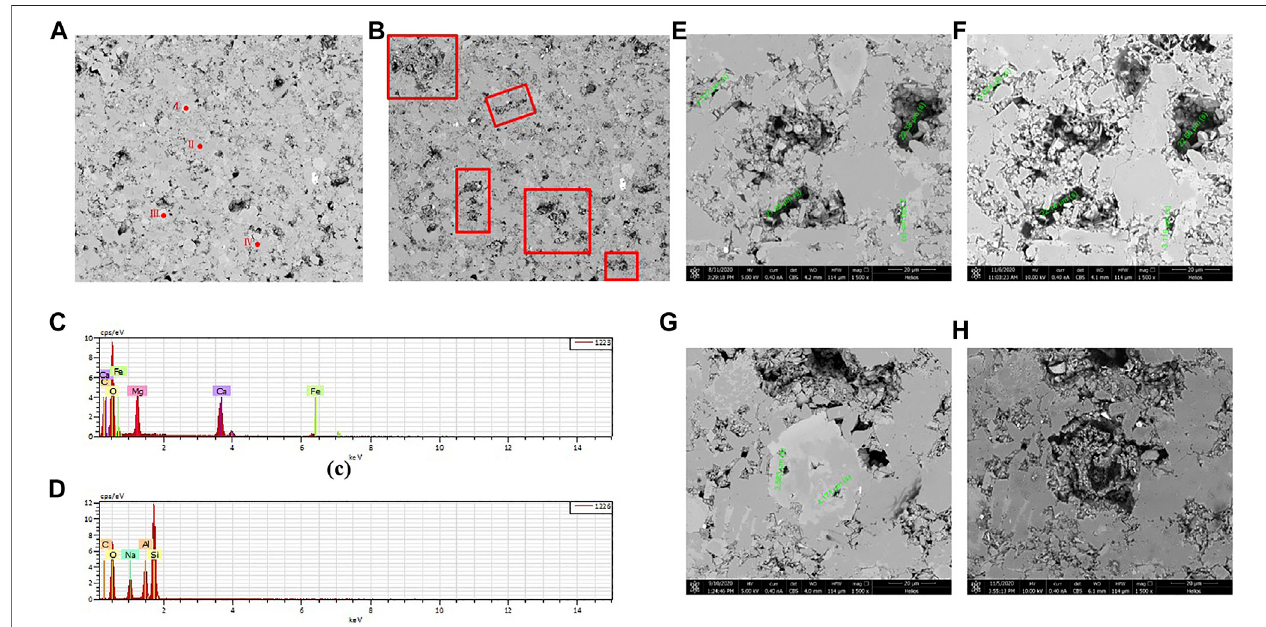
FIGURE 9 | The pore structure before and after soaking with CO 2 solution and EDS analysis results: (A) The pore structure before soaking; (B) The pore structure aftersoaking; (C) EDSanalysisresultsofPosition Ⅰ ; (D) EDSanalysisresultsofPosition Ⅱ . (E) Position Ⅲ beforedissolution; (F) Position Ⅲ afterdissolution; (G) Position Ⅳ before dissolution; (H) Position Ⅳ after